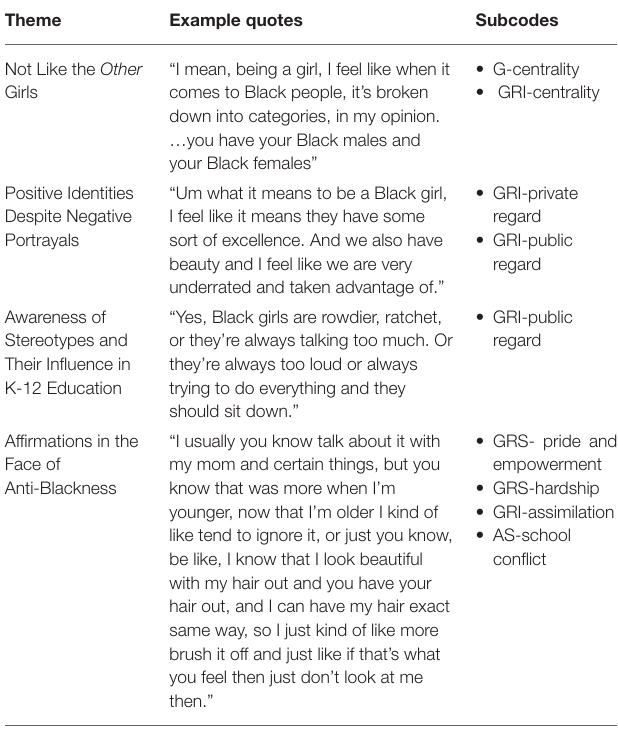
TABLE 2 | Theme, example quotes, and subcodes for research question